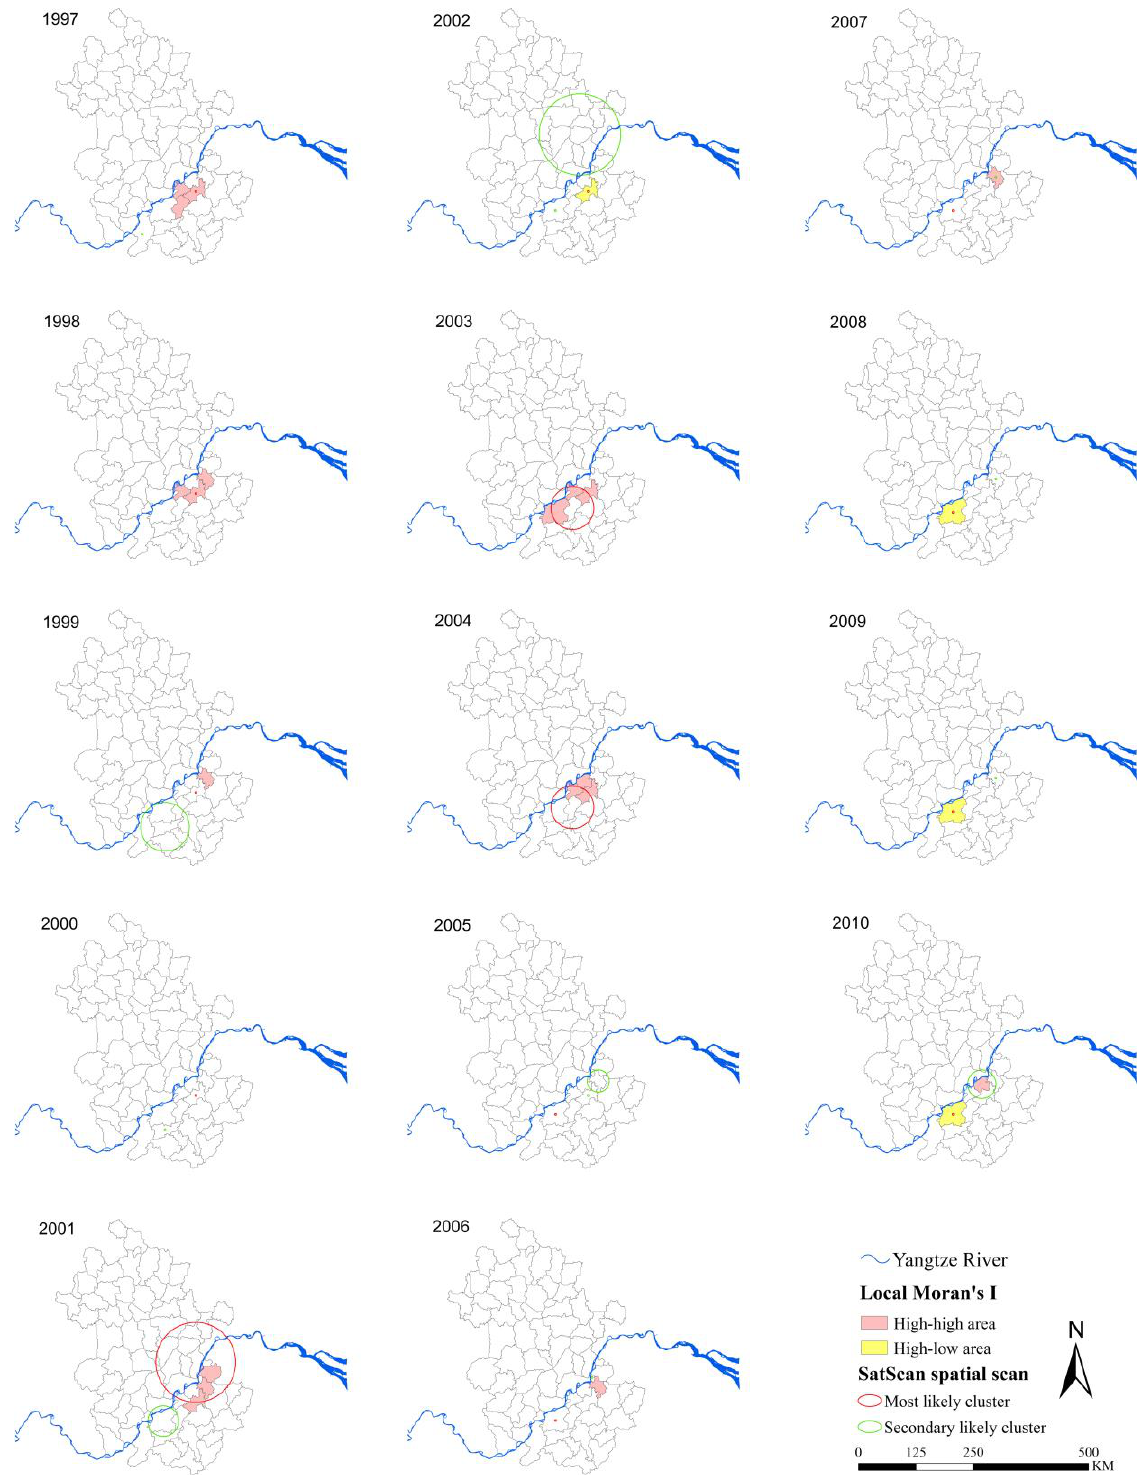
Figure 4. Annual spatial clusters of schistosomiasis during 1997–2010. Each panel shows the results of both methods for each year, the Anselin’s local Moran’s I test and the Kulldorff’s spatial scan statistics. The maps were created using the ArcGIS 10.0 software (ESRI Inc., Redlands, CA,